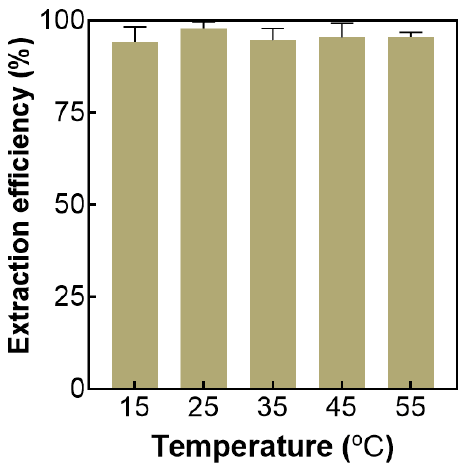
Figure 4. Effect of extraction temperature on the extraction efficiency of AMP. The fixed extraction condition: the K 3 PO 4 concentration was 41 wt%.